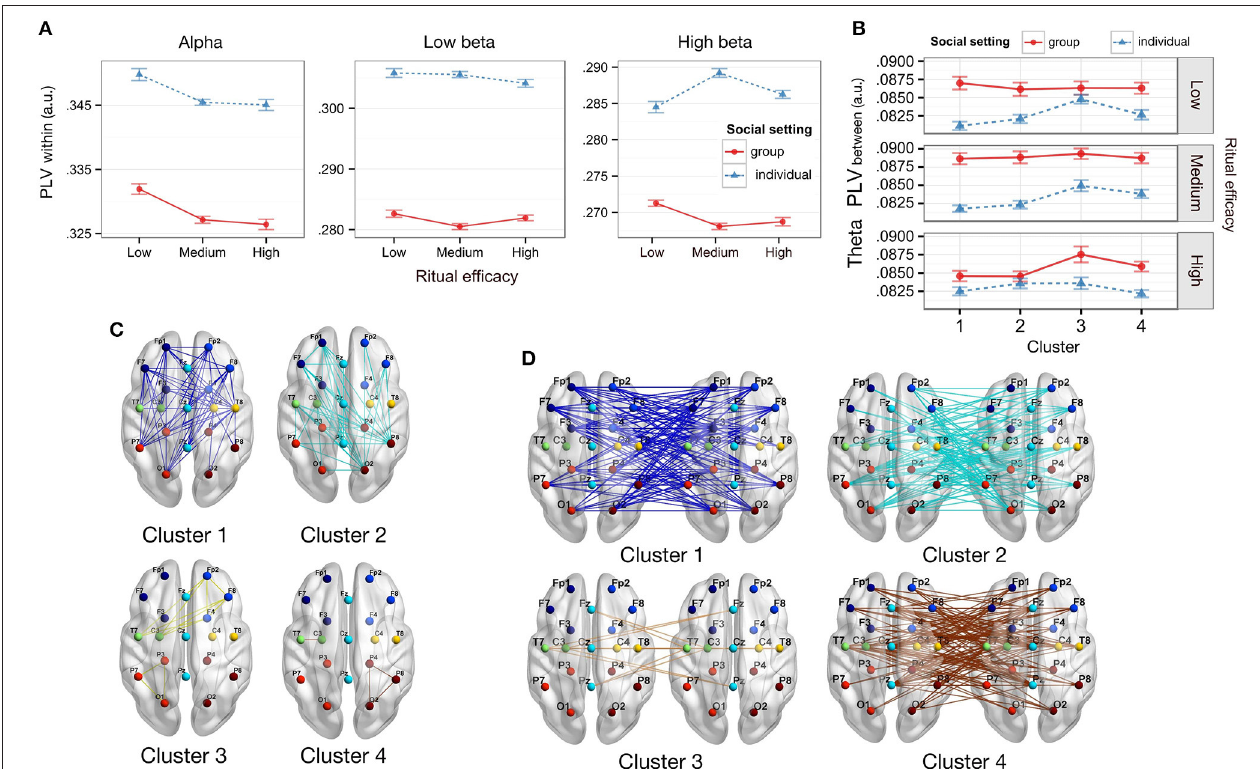
FIGURE 3 | Within- and between-participant phase synchrony correlates of perceived ritual efficacy. (A) Within-participant PLV by efficacy and social setting. Alpha band PLV decreased for low efficacy rituals. Low beta PLV decreased in the group as compared to individual setting. High beta PLV decreased in the group Social setting for medium and high efficacy rituals. (B) Theta between-participant PLV by Efficacy and Social setting. Group setting heightens between-participant PLV over individual setting in theta band for low efficacy in anterior and posterior ROI (cluster 1) (C) Within-participant ROI PLV clusters. (D) Between-participant ROI PLV clusters. Error bars represent within-participant standard error of the